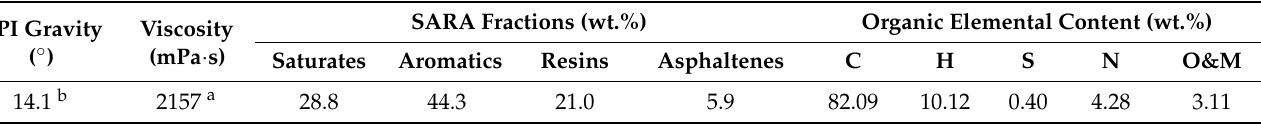
Table 3. Properties, chemical composition, and SARA fractions of heavy crude oil.